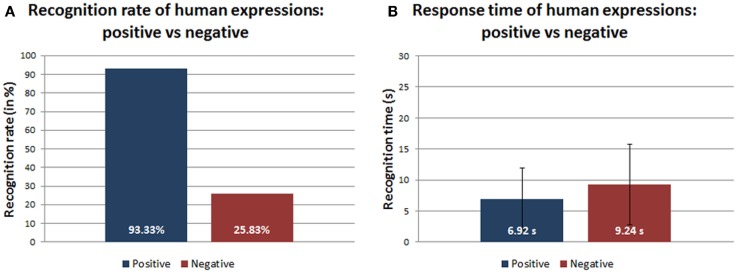
(A) Recognition rates (in percentage) and (B) response time (in seconds) of positive/negative human expressions.